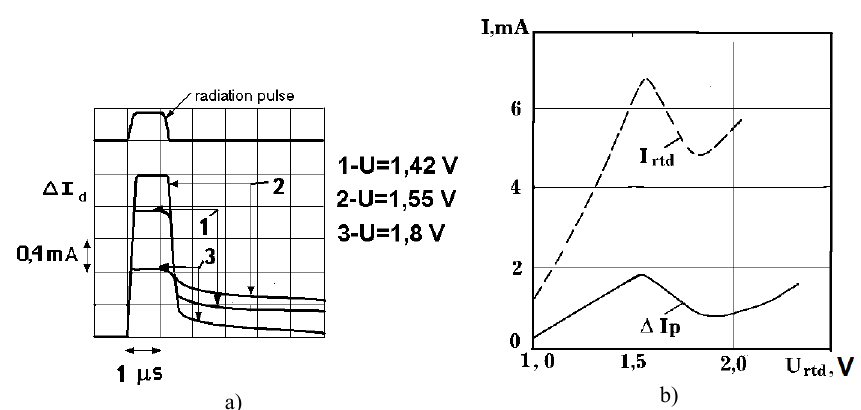
Fig. 5. RTD current response to pulse laser ionization (a) and curent value dependence on forward volatge (b) at equivalant dose rate value P= 3·10 8